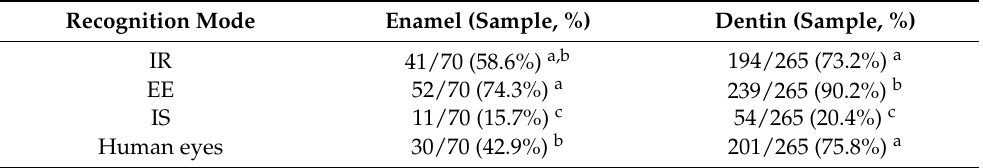
Table 4. A comparison of the performance of IR, EE, and IS recognition modes and human eyes in detecting proximal caries at the enamel and dentin